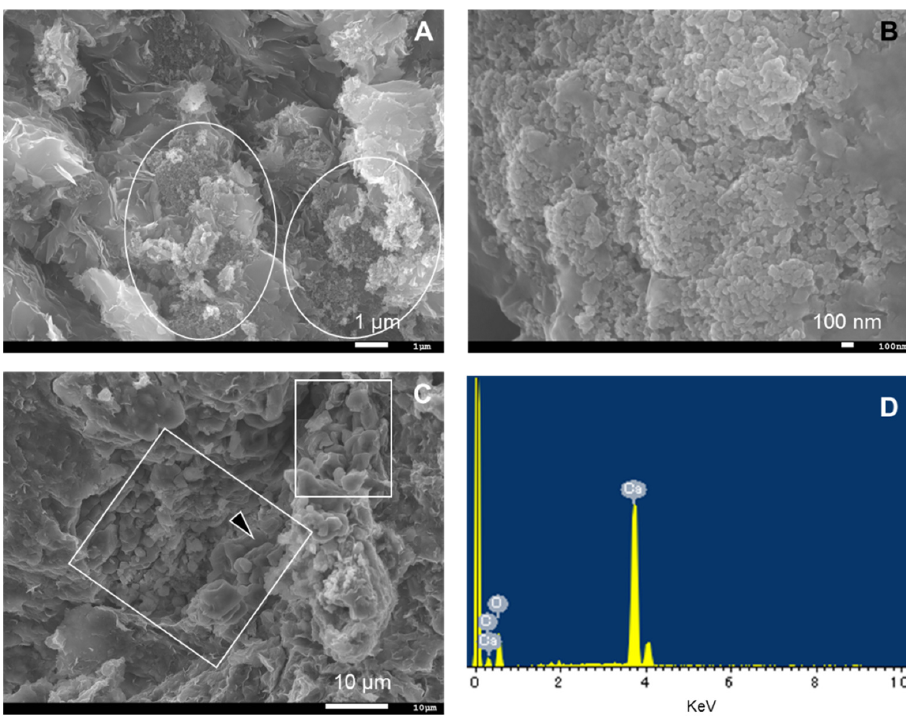
Figure 4. SEM images and EDS analysis of bentonite in BCI-15. ( A ) Montmorillonite and cristobalite (in white circle), ( B ) fine particles of cristobalite, ( C ) calcite (in white square), and ( D ) EDS spectrum of calcite at point indicated by the arrow in ( C ).